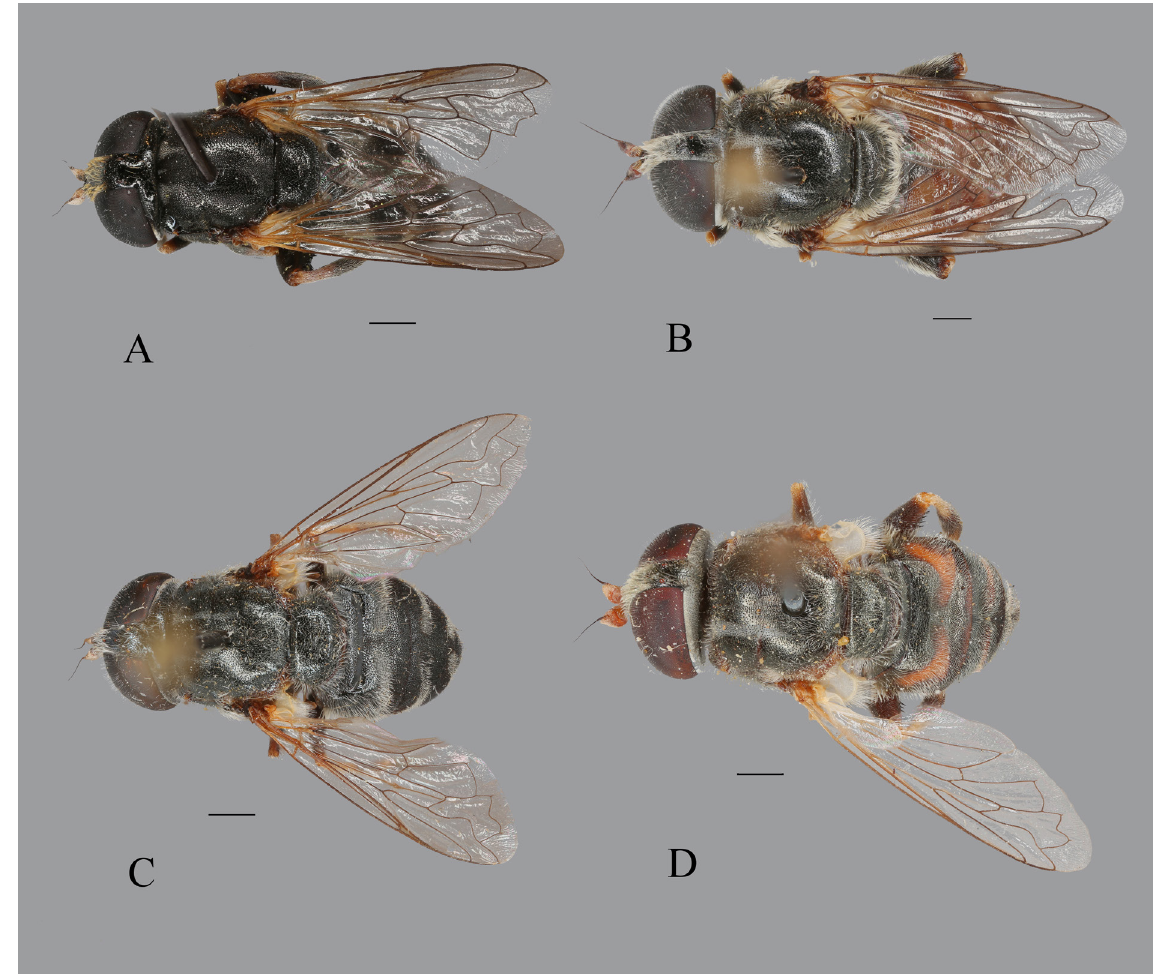
Fig. 5. Adult habitus, ♀, dorsal view. A . Eumerus brevipilosus Gilasian & van Steenis sp. nov., paratype (HMIM). B . E. coeruleus (Becker, 1913), Ghoochan, Iran (HMIM). C . E. longitarsis Peck, 1979, Mian Jangal, Iran (JSA). D . E. persarum Stackelberg, 1961, Bazman, Iran (JSA). Scale bars = 1.0